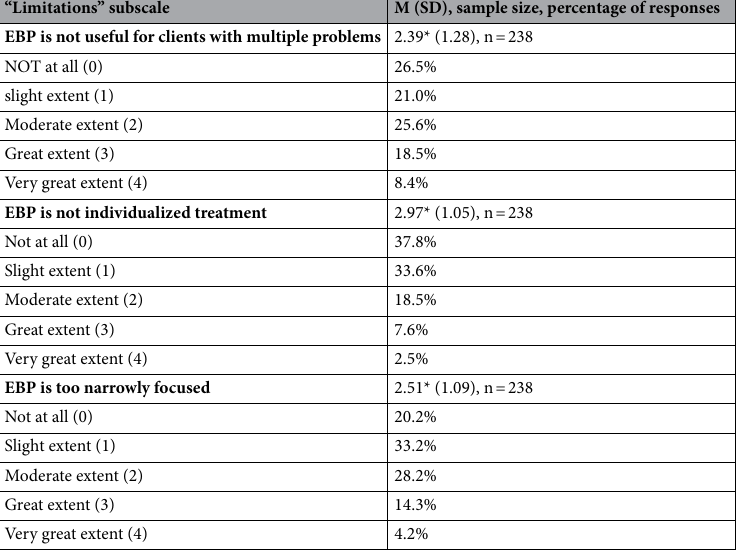
Table 2. EBPAS-36 “Limitations” subscale. * Reversed ratings; a higher value indicates a more positive attitude toward EBP. Abbreviations: EBP = evidence-based practice, EBPAS-36 = Evidence-Based Practice Attitude Scale-36, M = mean, n = number of respondents, SD = standard deviation.